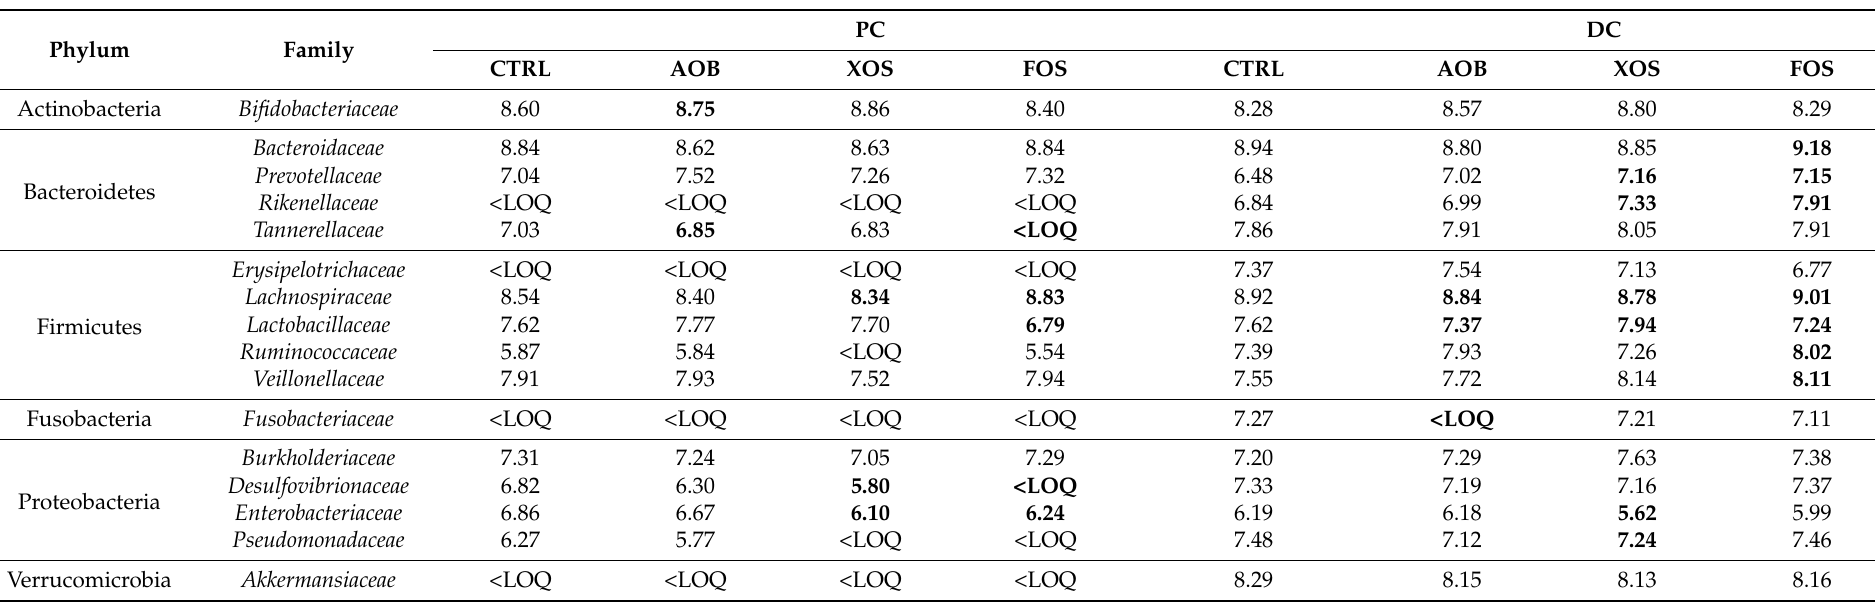
Table 1. Average microbial abundances at family level (log(cells/mL)) as detected via quantitative 16S rRNA gene-targeted Illumina sequencing of AOB, XOS and FOS versus a blank control during 2 weeks of treatment ( n = 4) for donor 2. Statistically significant differences between the control and treatments are indicated in bold ( p < 0.05). PC = proximal colon; DC = distal colon; CTRL = control; AOB = antioxidant blend; XOS = xylooligosaccharides; FOS =